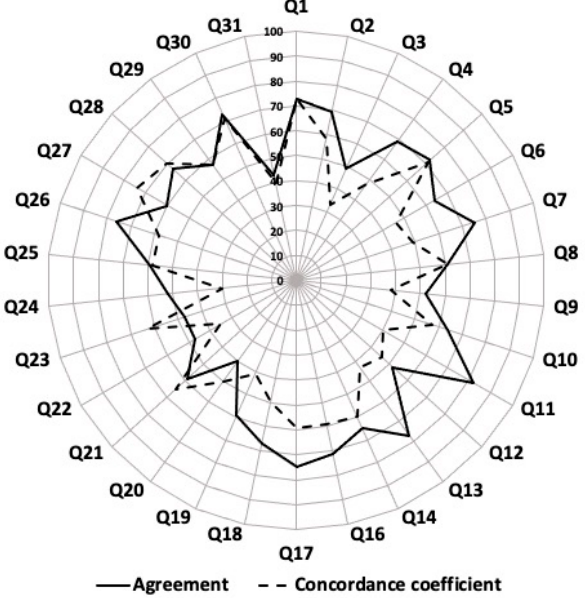
Figure 4. Agreement and concordant coefficient of every question of the Children and Adolescents Physical Activity and Sedentary-Questionnaire (CAPAS-Q) for the overall sample.